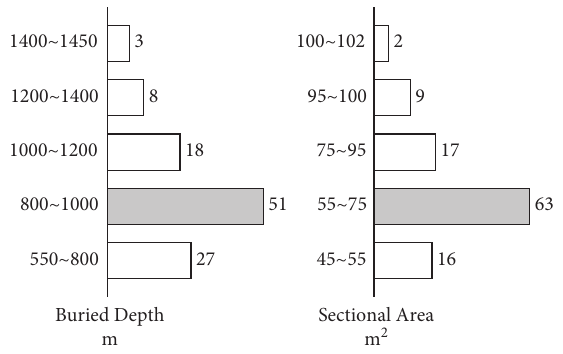
Figure 1: Distribution of tunnel characteristics in the research database (data source: collected by the study).